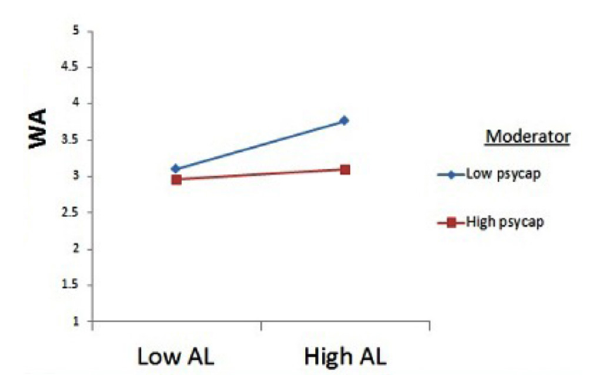
FIGURE 3 | Moderating role of psychological capital between aversive leadership and work